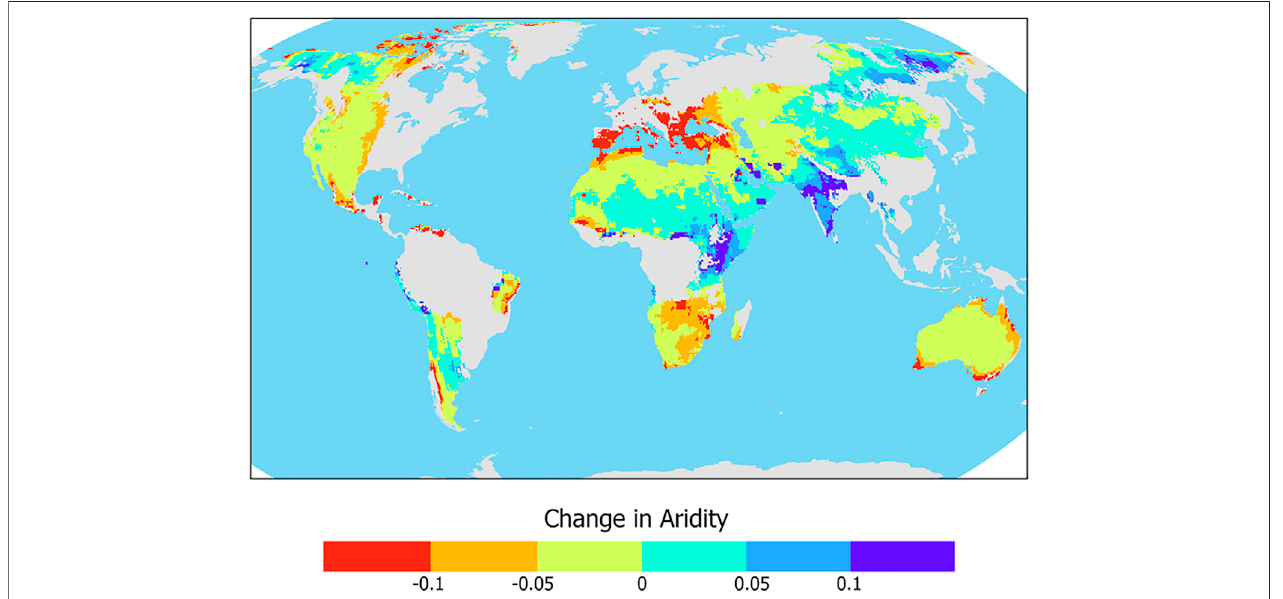
FIGURE4| Changeinaridity(P/PET)projectedfor2076 – 2100relativeto2006 – 2025averagedacross22 GCMparticipatingintheclimatemodelinter-comparison project(CMIP5)forcontinuedgreenhousegasemissionsandacumulative8.5 Wadditionalradiativeforcing(RCP8.5).FigurereproducedfromoriginalanalysisofZarch et al.,